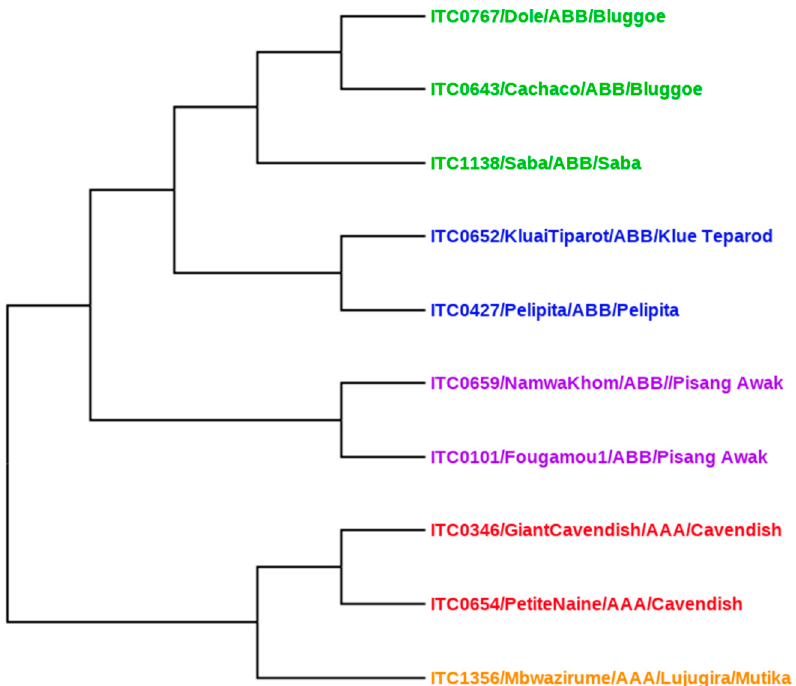
Figure 6. Construction of Neighbor Joining (NJ) tree using all test cultivars.